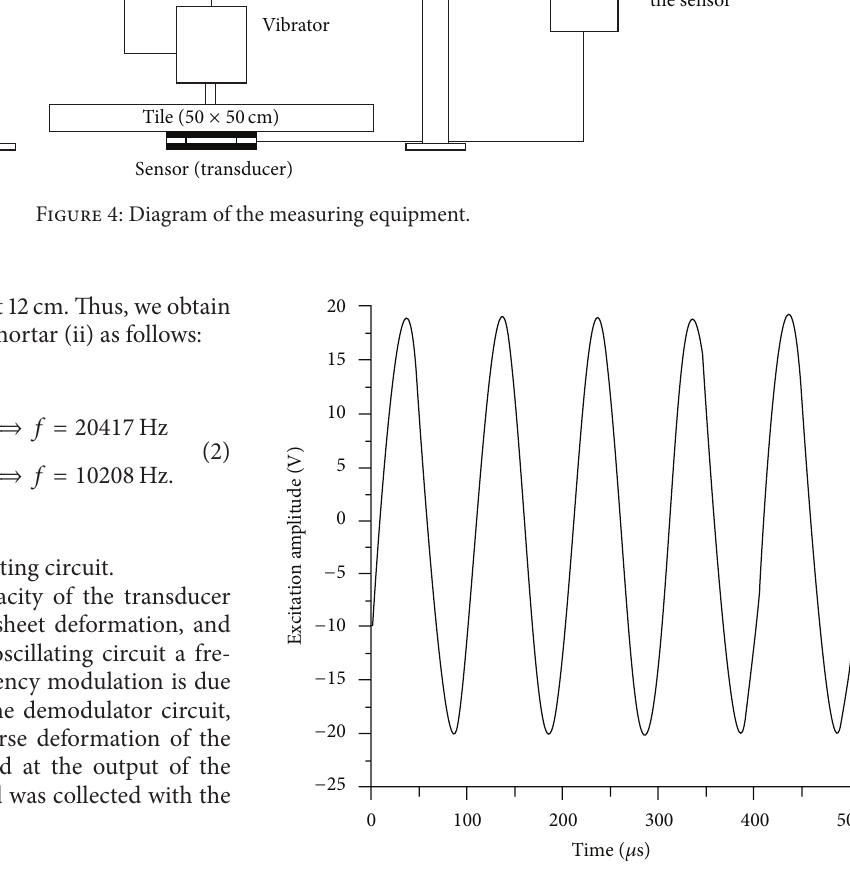
Figure 5: Excitation signal with a frequency of